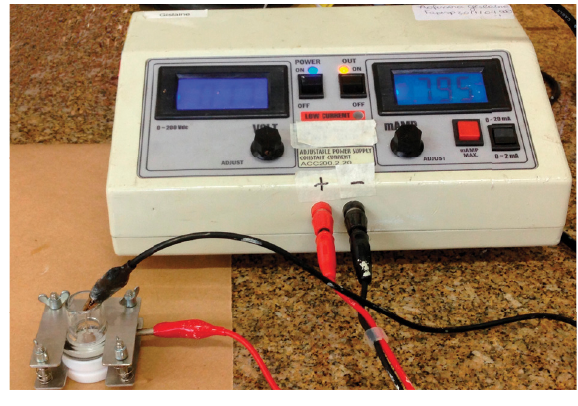
Figure 3. Iontophoresis equipment, showing a connected chloride silver electrode (cathode) inserted in the donor compartment and a silver electrode (anode) placed on the side of the cell, against the dental block, thus closing the electrical circuit for the passage of electric